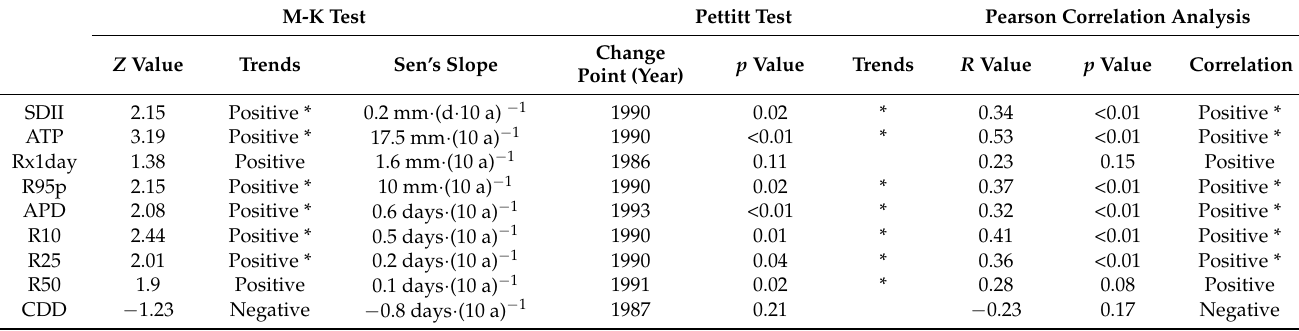
Figure 8. Spatial variation trend of precipitation indices in Jinan City during the period of 1979–2017. Table 6. The impact of urban expansion on precipitation in Jinan City during